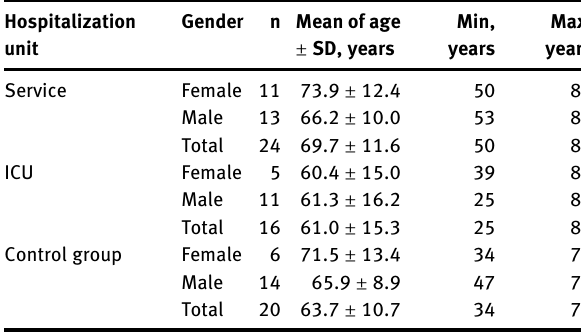
Table  : Age and gender distribution of the patient and control